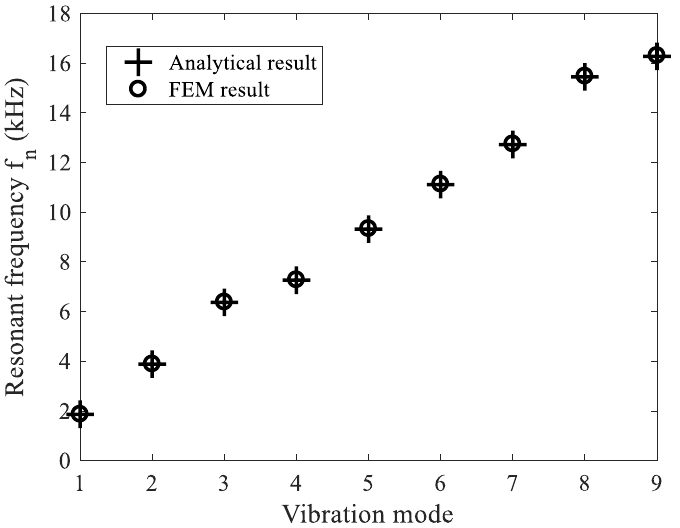
Figure 5. Comparison between the analytical and FEM results of the resonant frequency of the vibration modes from a clamped circular plate.